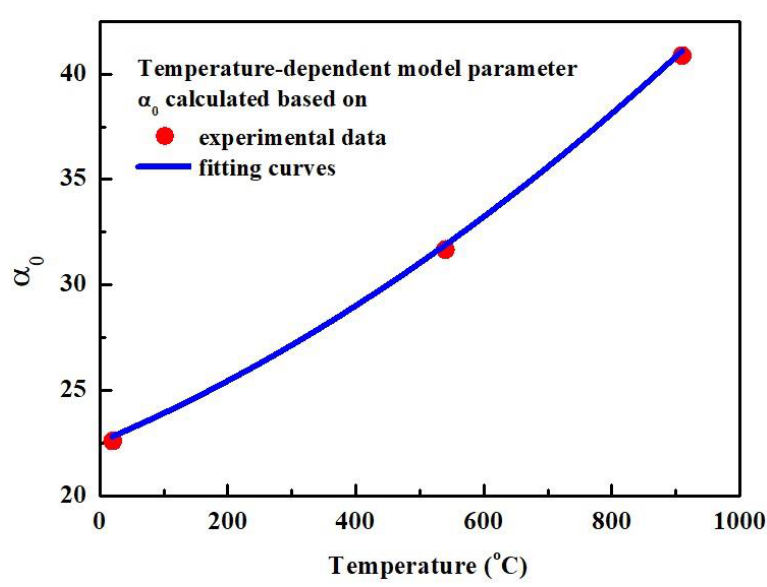
Figure 1. The calculated α 0 versus temperature for EB-PVD TBCs under solid particle erosion. Unlike the parameters α 0 and n , it is evident that the calculated cutting wear kinetic energy φ and deformation wear kinetic energy ε are more dependent on a variation in temperature, as shown in Table S2 of the Supplementary Materials. Hence, in the present study, it is suggested that the cutting wear kinetic energy φ and deformation wear kinetic energy ε are governed by multiple